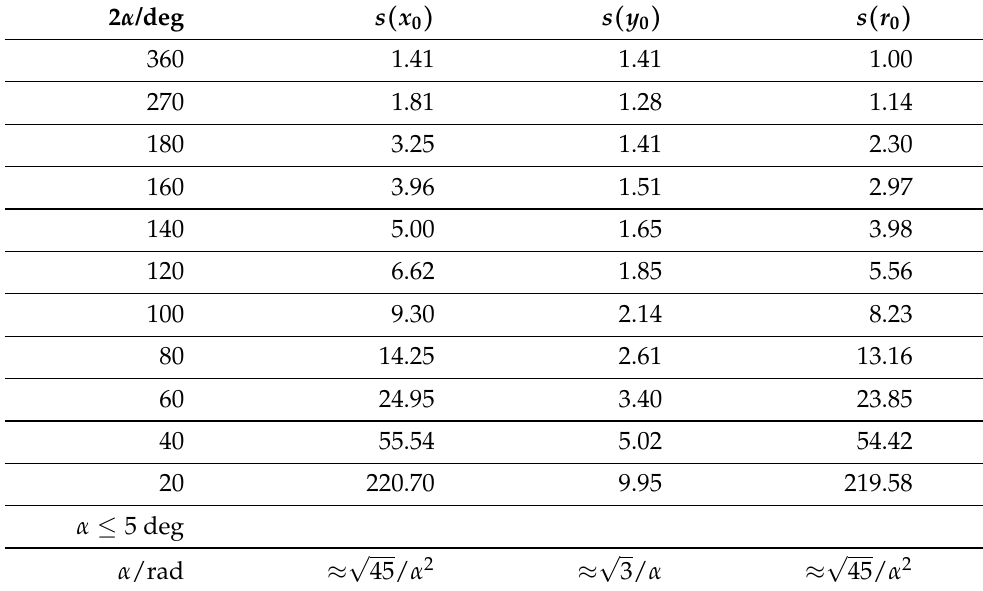
Table 1. Arc of a circle. Square roots s ( a ) of the diagonal elements of V α . For points x 1: m approxi- mately uniformly distributed on the arc of the circle defined by − α ≤ θ i ≤ α and for point-cloud √ I , the uncertainties u ( a ) = σ R s ( a ) / m . variance matrix σ 2 R 2 α /deg s ( x 0